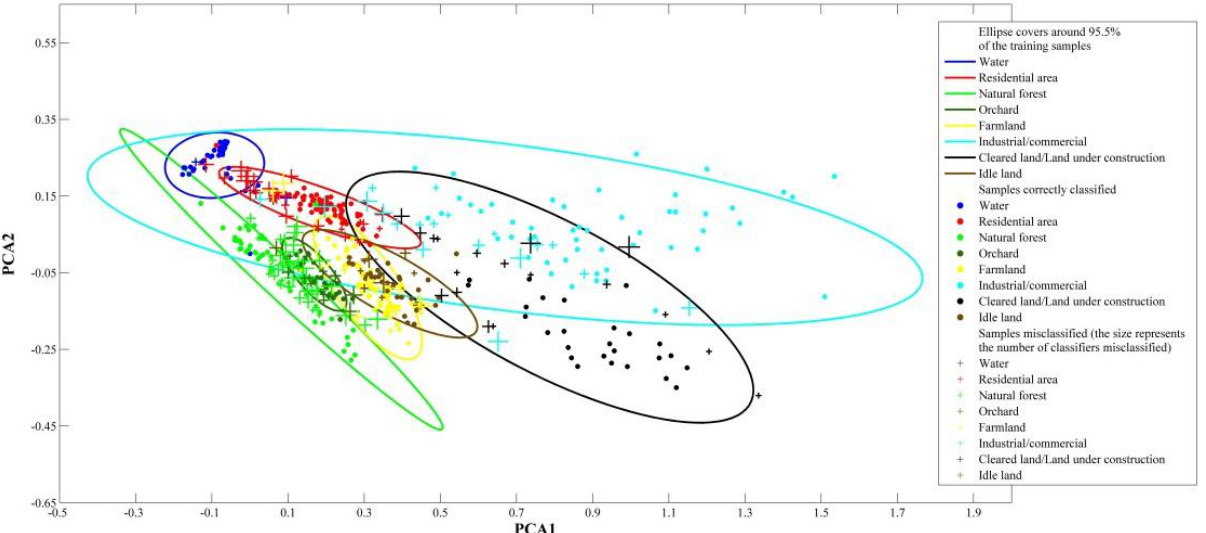
Figure 4. The distribution of the test samples in the feature space (principal component analysis (PCA) is used to reduce the dimension of data